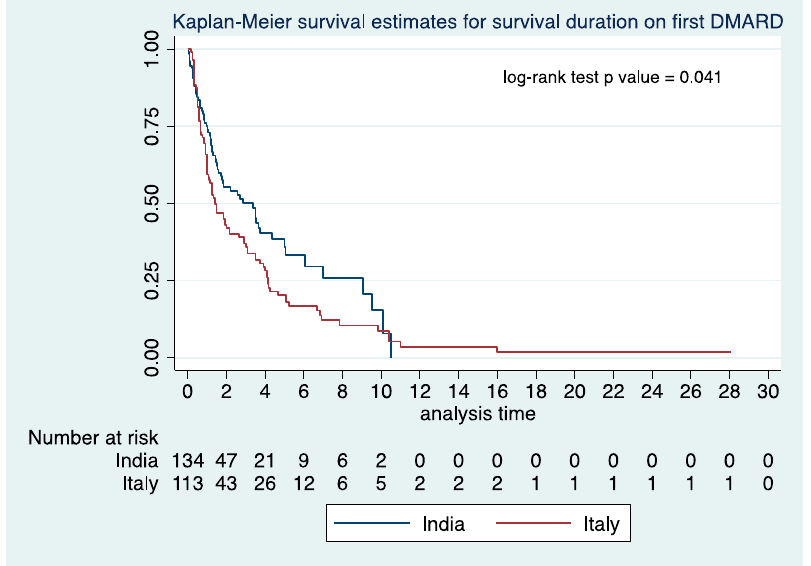
Figure 4. Survival on first DMARD in patients with Takayasu arteritis from Italy and India. DMARD—Disease-modifying anti-rheumatic drug.